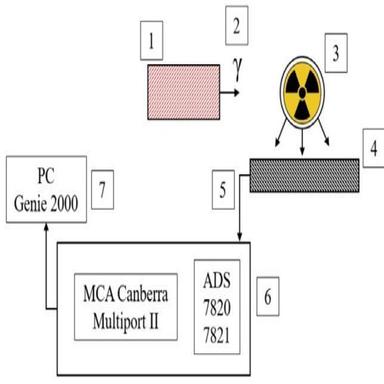
Schematic layout of the setup.